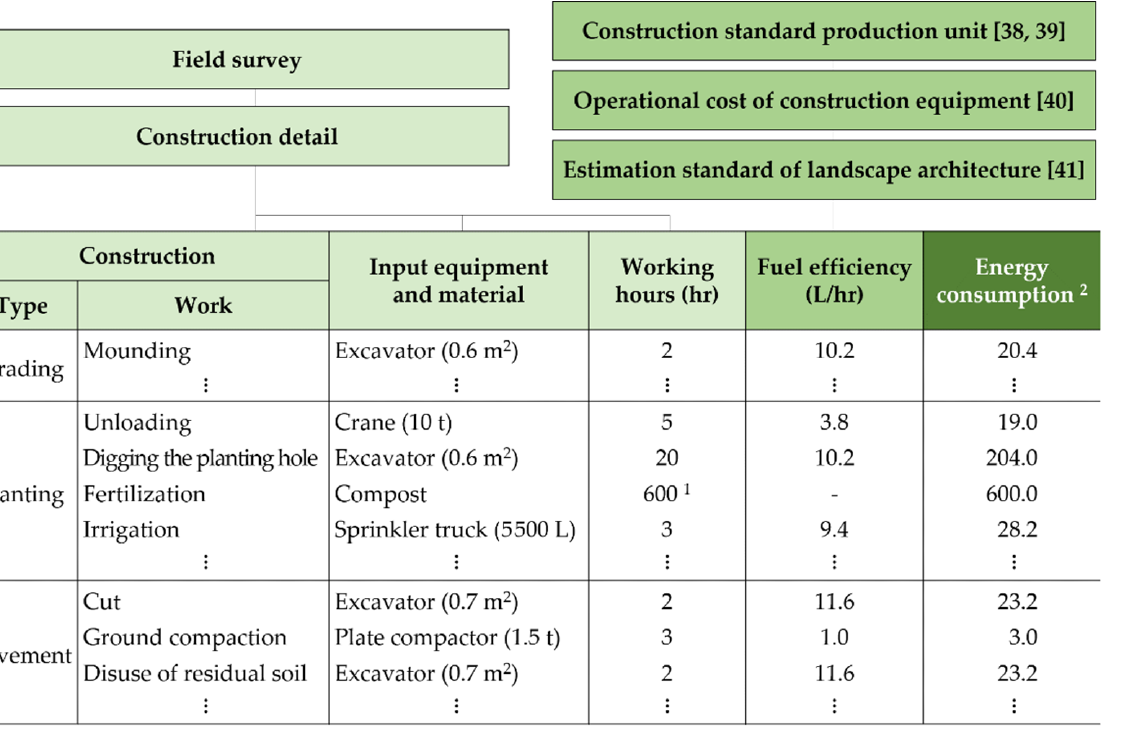
Figure 5. The process of energy consumption calculation in the construction stage [38–41]. 1 Amount of compost used (kg). 2 Diesel consumption (L) for excavator, crane, and sprinkler truck, and gasoline consumption (L) for plate compactor.